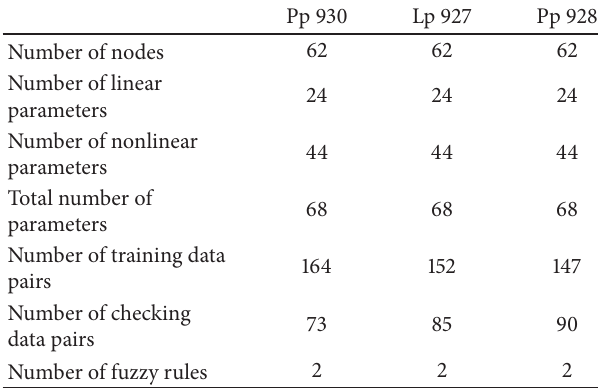
Table 3: ANFIS model